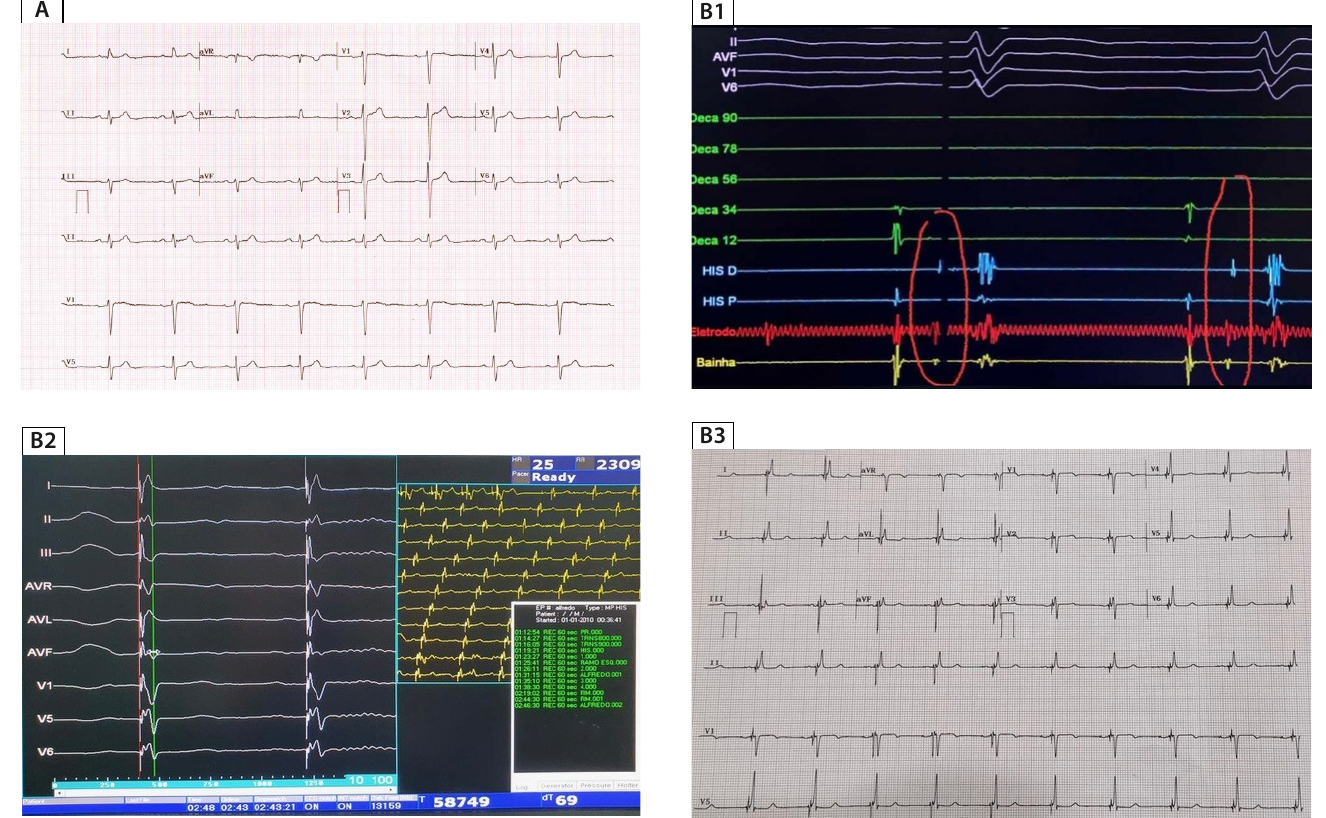
Fig. 2 - Physiological ventricular pacing on electrocardiogram. A) Baseline electrocardiogram with intrinsic QRS; B1) Signaling of His (100ms sweep speed) previous to lead deployment; B2) QRS duration during artificial pacing with bundle of His capture (Conduction System Pacing); B3) Final ECG with Conduction System Pacing and near intrinsic morphology of the paced